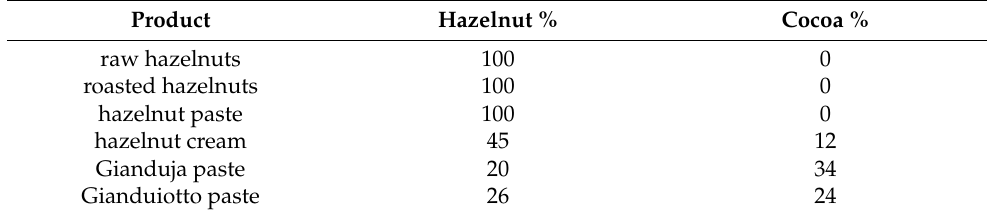
Table 1. Average compositions of the products.